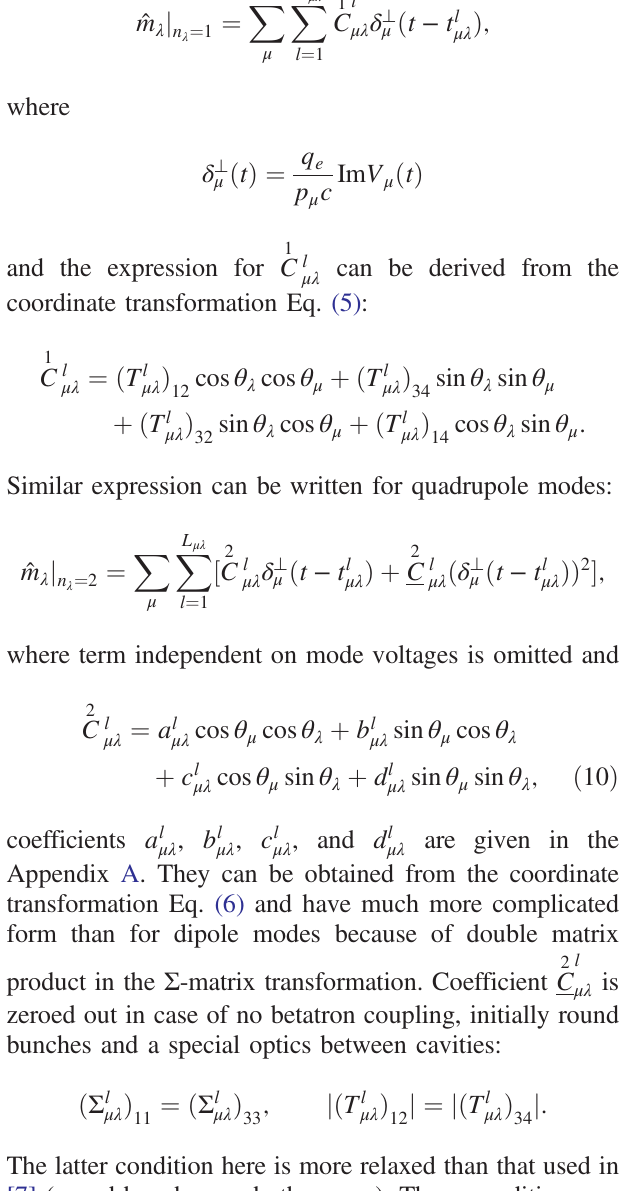
FIG. 3. Interaction loops between accelerating modules in ER operating mode of